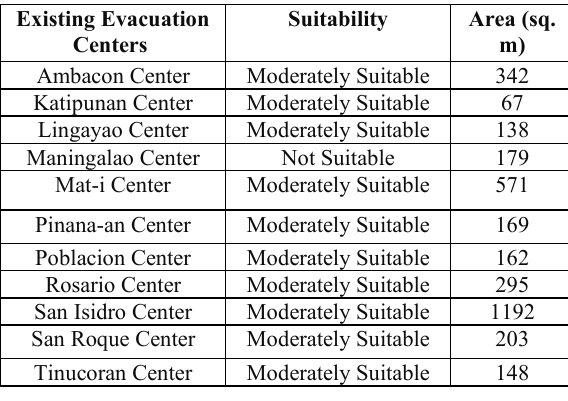
Table 5. Statistics of Existing Evacuation Centers Suitability